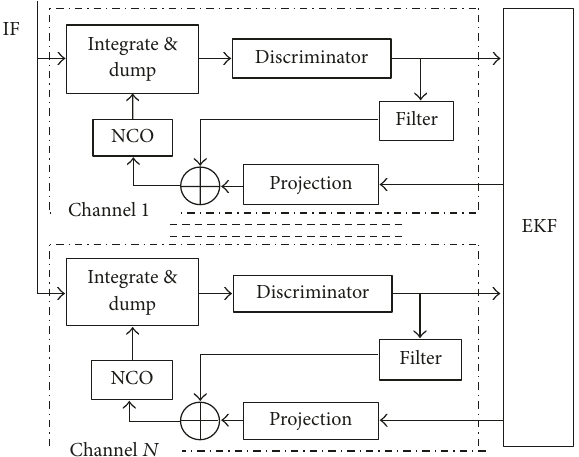
Figure 1: The joint VPLL architecture for carrier phase tracking.